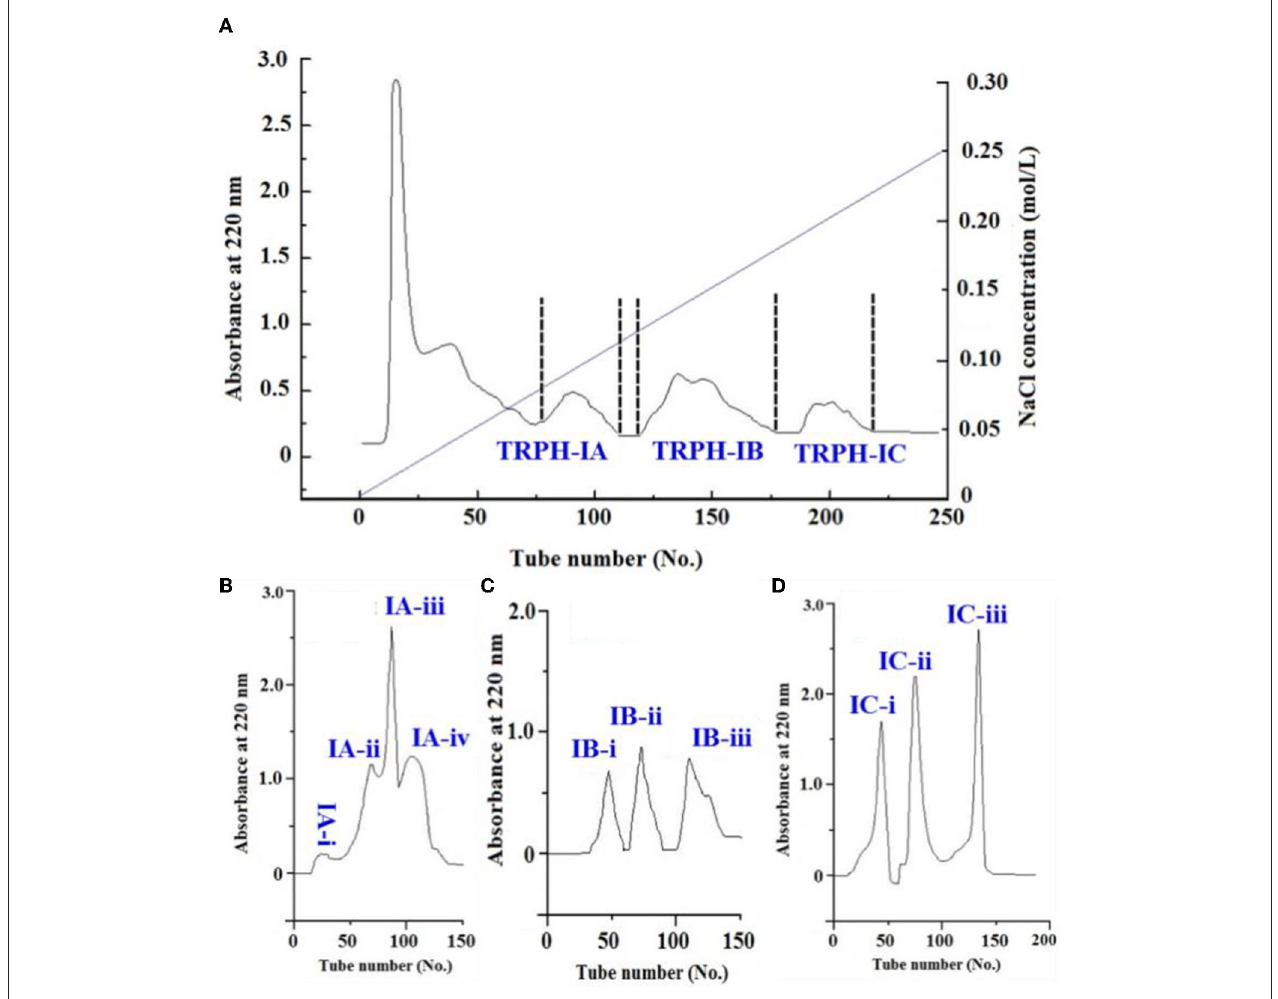
FIGURE 3 | Separation of TRPH-1 by DEAE-52 cellulose anion-exchange chromatography (A) and Sephadex G-25 gel filtration chromatography (B–D)